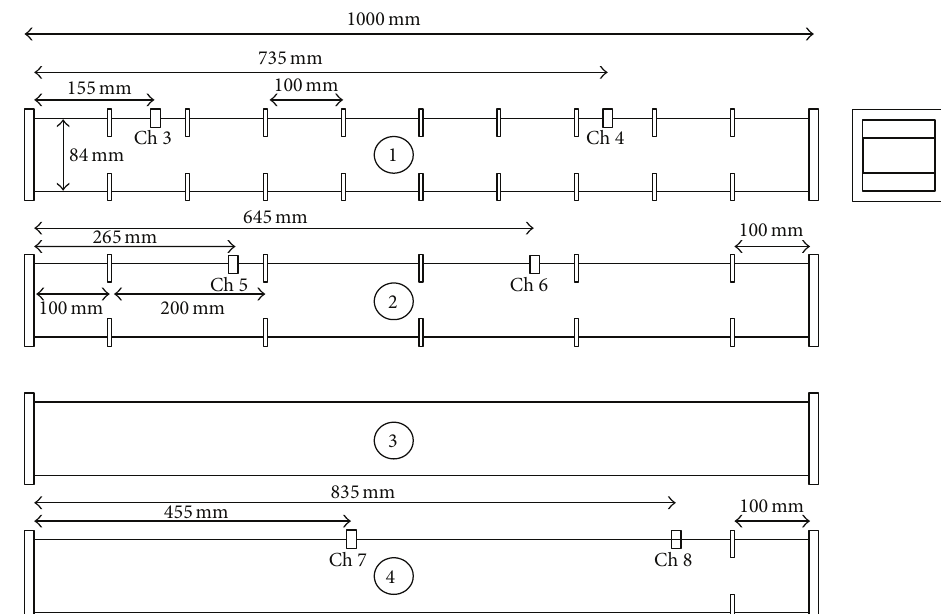
Figure 4: Schematic drawing of the experimental setup. Ch# = pressure recording channel number.